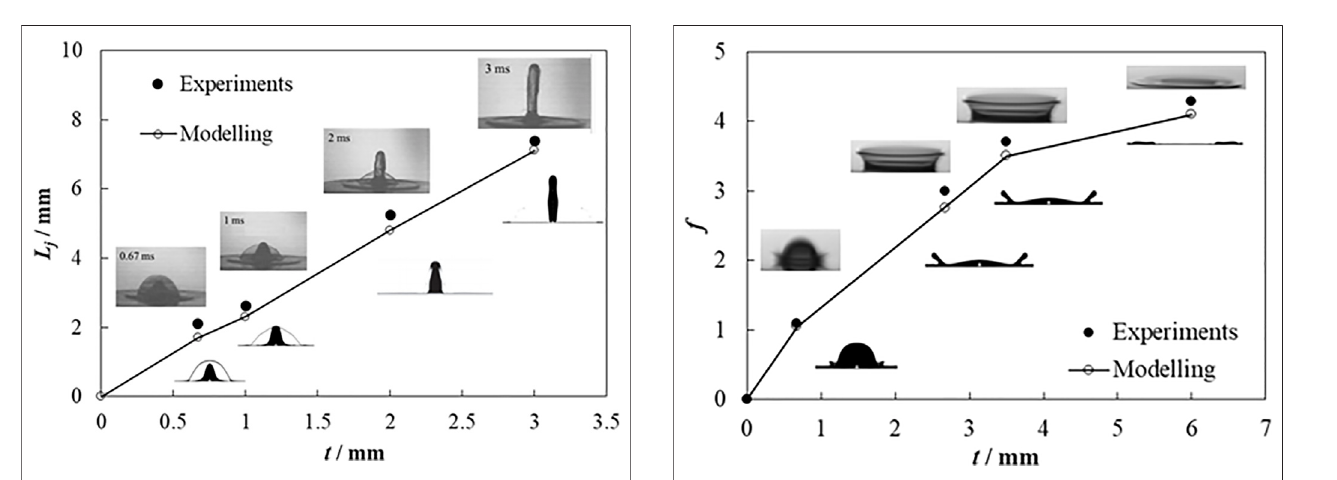
FIGURE4| Comparisonoftheexperiment(Lietal.,2017)andsimulation results for the continuous dense